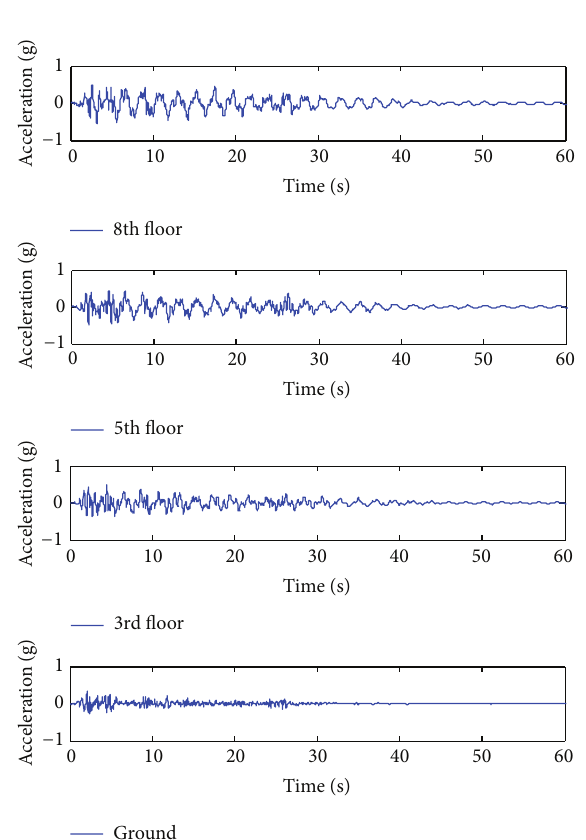
Figure 4: Ground and numerically calculated floor acceleration time histories of 8-story